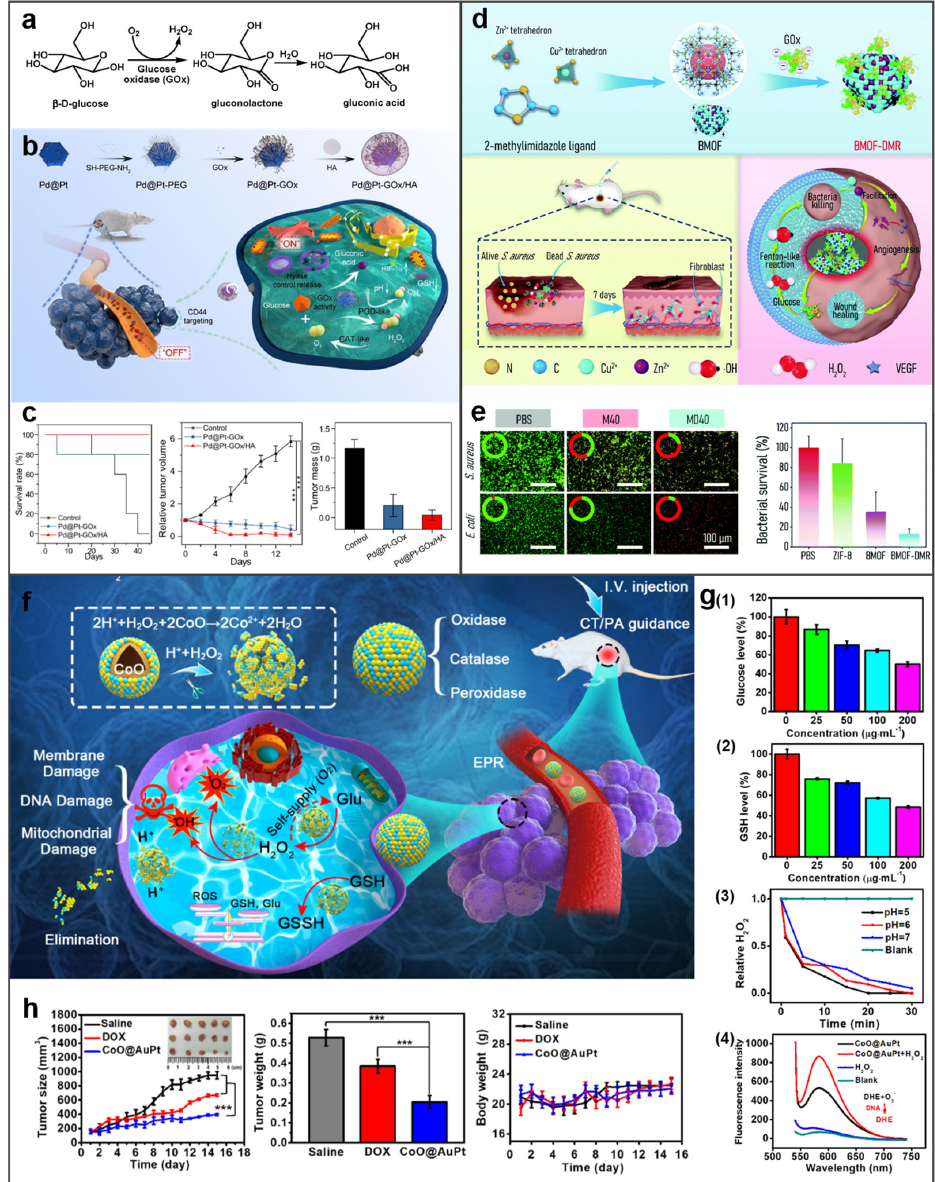
Figure 8. The applications of BMNs in starvation therapy and radiation therapy. ( a ) Mechanism of action of glucose oxidase. ( b ) Nanozyme-mediated starving-enhanced CDT of the Pd@Pt-GOx/HA nanoreactors. Reprinted with permission from Ref. [115]. ( c ) Antitumor effects through the nanozyme- mediated starving-enhanced cancer therapy in the 4T1 model (survival rates, tumor growth curves, and tumor mass). Reprinted with permission from Ref. [115]. Copyright © 2020 American Chemical Society. ( d ) Therapeutic effect toward bacteria-induced wound healing and killing bacteria by the BMOF-DMR. Reprinted with permission from Ref. [116]. ( e ) The antibacterial effect of BMOF-DMR in the wound (fluorescence images of live/dead staining of S. aureus and E. coli ; the surviving bacteria rates). Reprinted with permission from Ref. [116]. Copyright © Royal Society of Chemistry 2022. ( f ) Schematic illustration of CoO@AuPt NPs working for augmented CDT. Reprinted with permission from Ref. [117]. ( g ) The enzyme-like activity of CoO@AuPt. Adapted with permission from Ref.